Question: Condense the content of this figure into a single sentence.
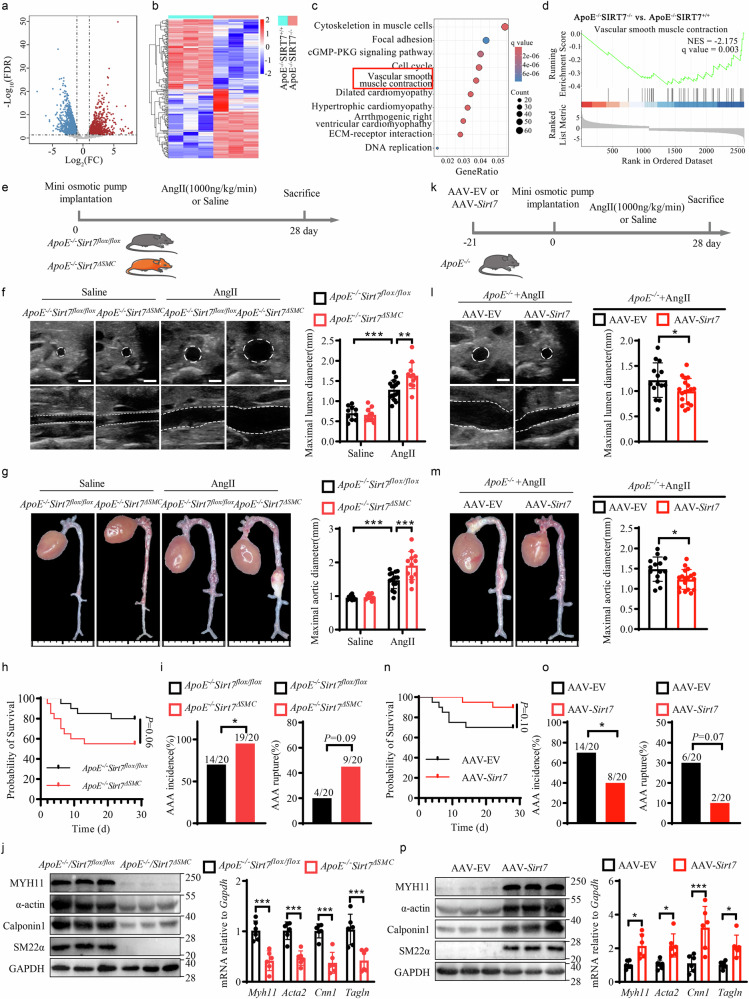
Answer: SIRT7 protected against AngII-induced AAA formation via modulating VSMC phenotypic switching. a – d ApoE −/− Sirt7 +/ + and ApoE −/− Sirt7 −/− mice were infused with angiotensin II (AngII) (1,000 ng/kg/min) for 4 weeks. Aneurysmal tissues were collected for RNA sequencing. a Volcano plot showing differentiated expressed genes (DEGs). Upregulated genes are shown in red dot ( n = 966), and downregulated genes are displayed in blue dot ( n = 1,310). DEGs were defined as genes with a Benjamini–Hochberg adjusted P -value < 0.05 and |log 2 (Fold change) |≥1. n = 3 per group. b Heatmap of DEGs in ApoE −/− Sirt7 +/ + and ApoE −/− Sirt7 −/− mice after AngII infusion. n = 3 per group. c Among the top 10 KEGG pathways of DEGs, vascular smooth muscle contraction (VSMC) was enriched. d GSEA of VSMC pathway in ApoE −/− Sirt7 +/ + and ApoE −/− Sirt7 −/− mice after AngII infusion. NES, Normalized enrichment score. e – j ApoE −/− Sirt7 flox/flox and ApoE −/− Sirt7 Δ SMC mice were infused with saline or AngII (1,000 ng/kg/min) for 4 weeks. e Schematic diagram of the AngII-induced abdominal aortic aneurysm (AAA) model in ApoE −/− Sirt7 flox/flox and ApoE −/− Sirt7 Δ SMC mice. f Representative ultrasonic images and quantitative comparison of maximal lumen diameter in ApoE −/− Sirt7 flox/flox and ApoE −/− Sirt7 Δ SMC mice after 28 days of AngII infusion. n = 10 for saline and n = 20 for AngII. Scale bar, 1 mm. g Representative macroscopic images and quantitative comparison of maximal aortic diameter in ApoE −/− Sirt7 flox/flox and ApoE −/− Sirt7 Δ SMC mice after 28 days of AngII infusion. n = 10 for saline and n = 20 for AngII. h Survival curves of AngII-induced AAA in indicated groups. n = 20 per group. i , The incidence and rupture rate of AngII-induced AAA in indicated groups. n = 20 per group. j , Relative protein and mRNA expression of SMC phenotypic switching marker ( Myh11 , Acta2 , Cnn1 , and Tagln ) in ApoE −/− Sirt7 flox/flox and ApoE −/− Sirt7 Δ SMC mice after 28 days of AngI